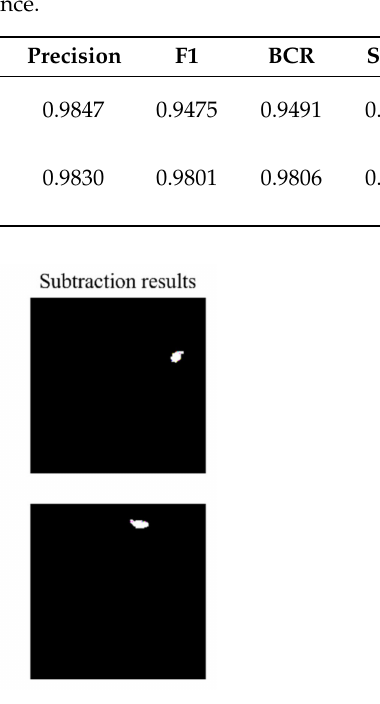
Figure 8. Results from the new PCB images. The defects of input images were artificially